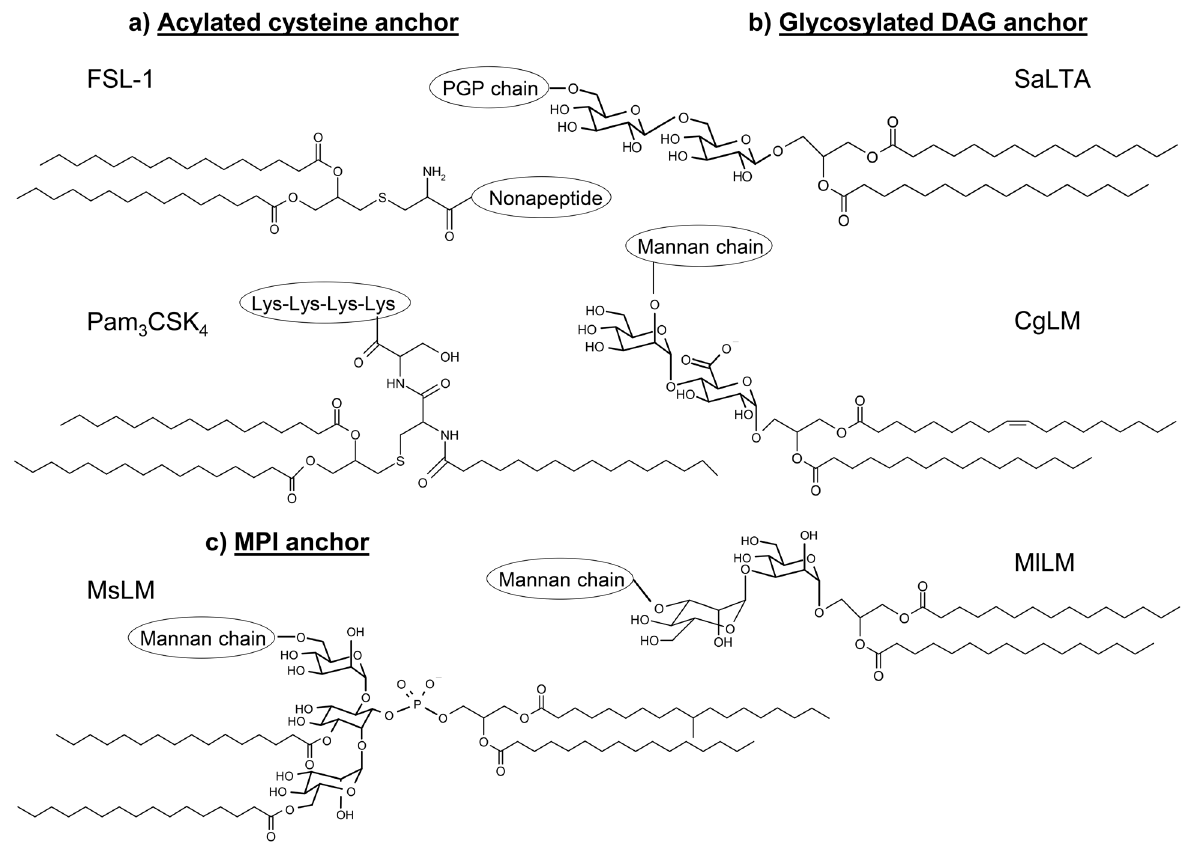
Figure 1. Structure of the lipid anchor of bacterial macroamphiphiles. CgLM, Corynebacterium glutamicum lipomannan; DAG, diacylglycerol; FSL-1, synthetic N-terminal part of lipopoprotein LP44 of Mycoplasma salivarum ; MlLM, Micrococcus luteus lipomannan; MPI, mannosyl-phosphatidyl- myo -inositol; MsLM, Mycobacterium smegmatis lipomannan; PGP, polyglycerolphosphate; SaLTA, Staphylococcus aureus lipoteichoic acid; The available evidence [29] suggests the structure of Stomatococcus mucilaginosus lipomannan (SmLM) is very similar to that of MlLM.